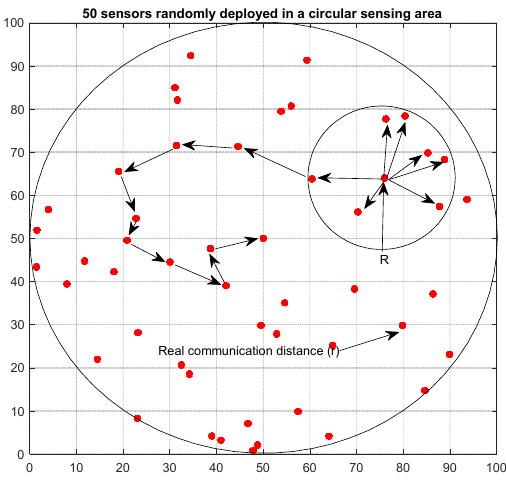
Figure 2. Sensor neighborhoods defined by the sensor transmission range